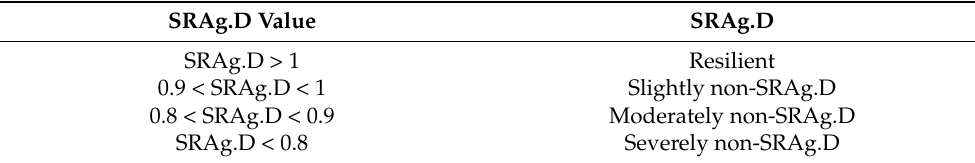
Table 4. Classification of sunflower resilience to Ag.D (SRAg.D) values, which ranged from resilient to severely non-resilient.